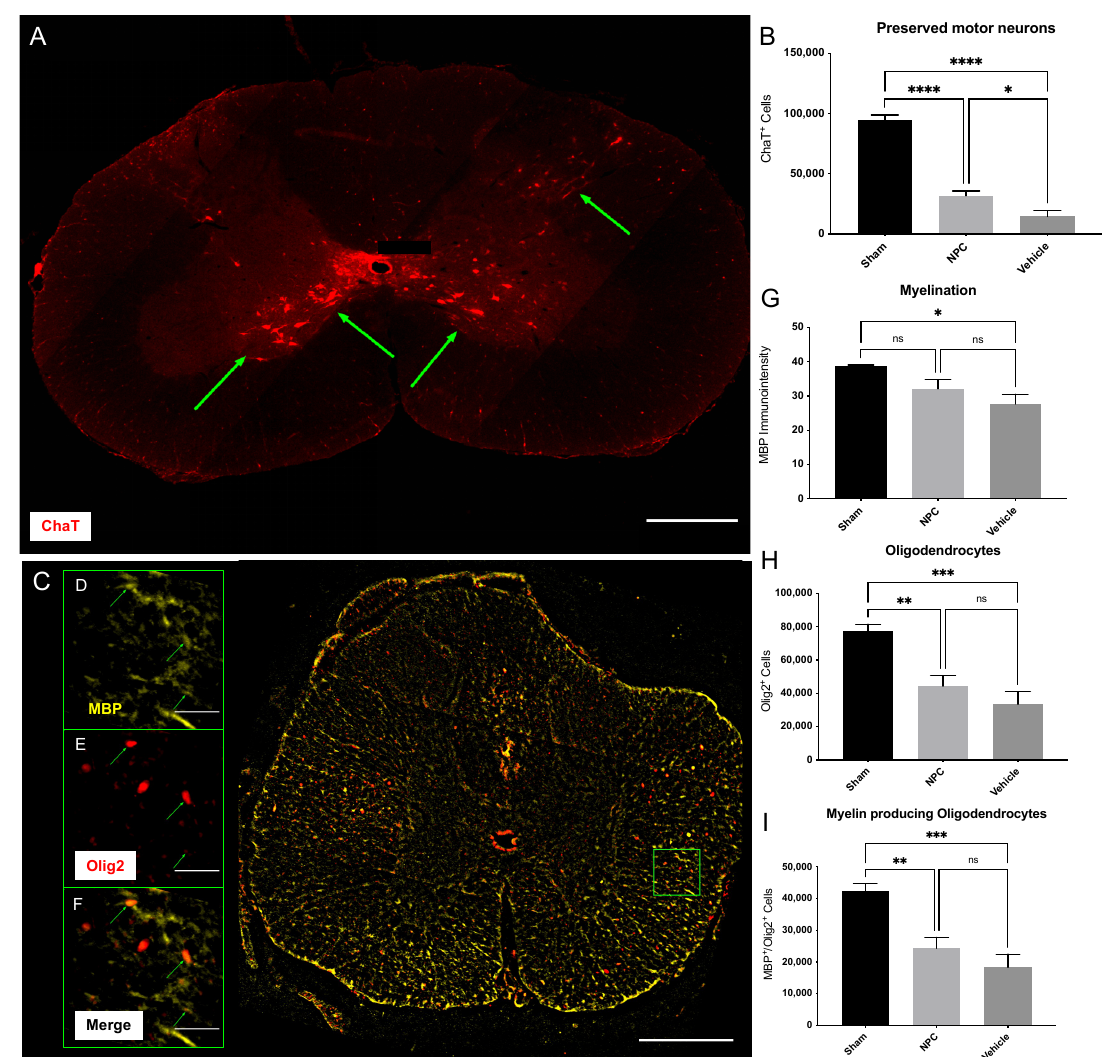
Figure 2. Spared motor neurons, oligodendrocytes, and myelination in the injured spinal cord eight weeks after severe cervical SCI. ( A ) Spinal cord cross-section of an NPC animal stained for the motor neuron marker ChaT, indicating spared motor neurons (green arrows) in the ventral grey matter at 10 × magnification (scale bar = 500 µ m). ( B ) Significantly more ChaT + motor neurons could be observed in NPC animals (group 1) compared to Vehicle animals (group 2; n = 8 animals per group; one-way analysis of variance (ANOVA) with post-hoc Tukey-HSD-test; p = 0.0336). ( C ) Spinal cord cross-section of a Vehicle animal stained for the oligendroglial marker Olig2 and the surrogate marker for myelin MBP at 10 × magnification (scale bar = 500 µ m). ( D – F ) Enlargement of the green framed inlet in ( C ), depicting the close spatial relationship (green arrows) of active Olig2 + oligodendrocytes and MBP at 40 × magnification (scale bar = 50 µ m). ( G ) The immuno-intensity of the MBP-staining and thus the extent of myelination showed no significant difference between NPC animals and Vehicle animals ( n = 8 animals per group; one-way ANOVA with post-hoc Tukey-HSD-test; p = 0.3945). Similarly, the number of Olig2 + oligodendrocytes ( H ) and Olig2 + /MBP + active oligodendrocytes ( I ) were not significantly higher in NPC animals compared to Vehicle animals (both n = 8 animals per group; one-way ANOVA with post-hoc Tukey-HSD-test; p = 04549) (* p < 0.05; ** p < 0.01; *** p < 0.001; **** p < 0.0001 and ns = not